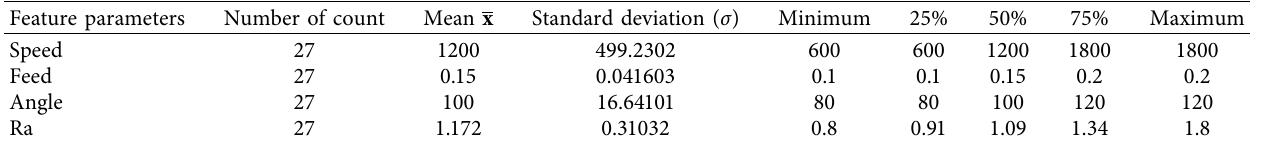
Table 2: Descriptive statistics of features used in the